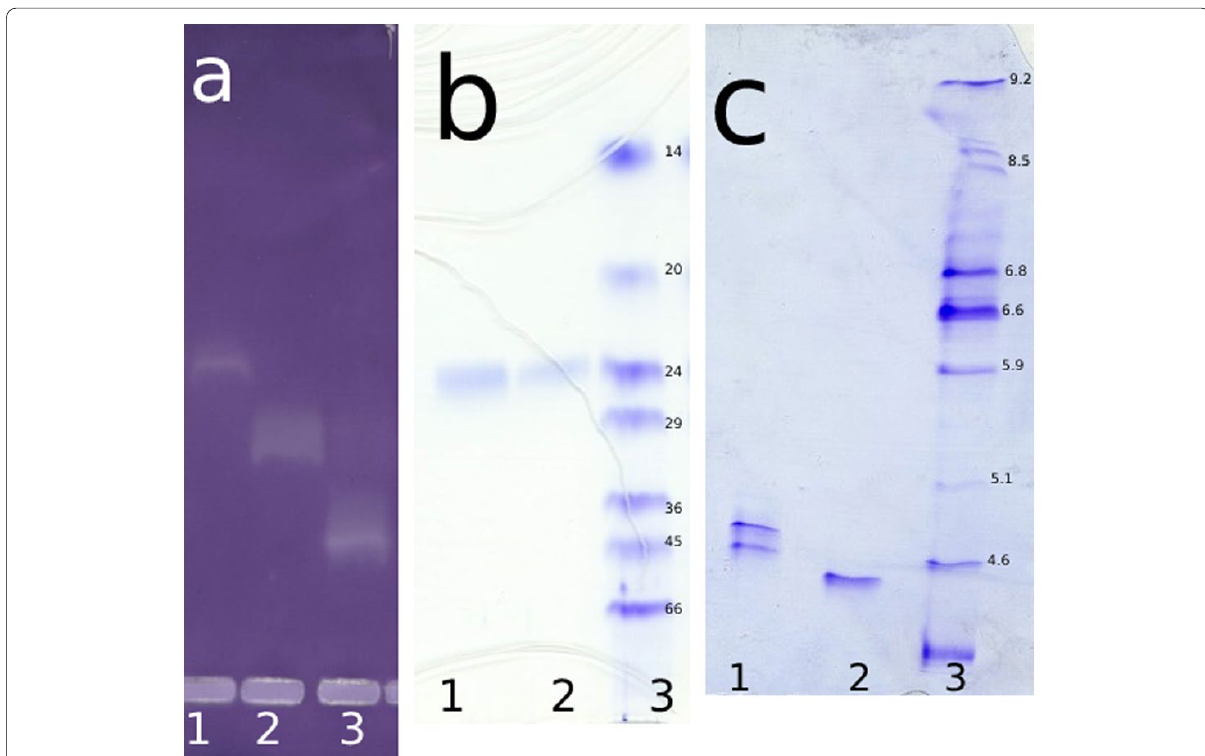
Fig. 2 a Native PAGE of B. alexandrina GSTs stained for (lane1: BaGST1, lane 2: BaGST2, and lane 3: BaGST3). b SDS‑PAGE of BaGST2 and BaGST3 stained for protein (lane 1: BaGST2, lane 2: BaGST3, and lane 3: Standard molecular weight markers). c foucusing of BaGST2 and BaGST3 (lane 1: BaGST2, lane 2: BaGST3, and lane 3: Standard isoelectric focusing markers)